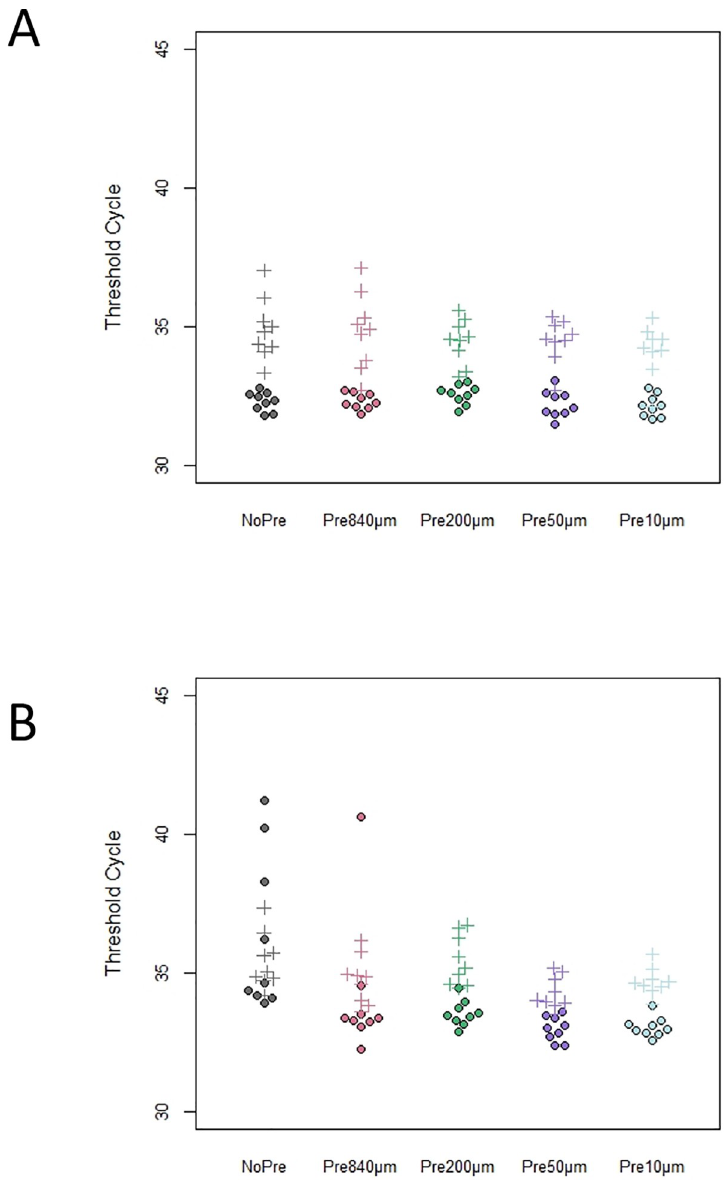
Fig 5. DNA detection assay (Threshold cycle, Ct) results for pale chub under each pre-filtration condition by qPCR. (A) In the absence of humin; B) in the presence of humin. Closed circles and daggers indicate the results detected by the THUNDERBIRD 1 qPCR Mix and Environmental Master Mix 2.0,